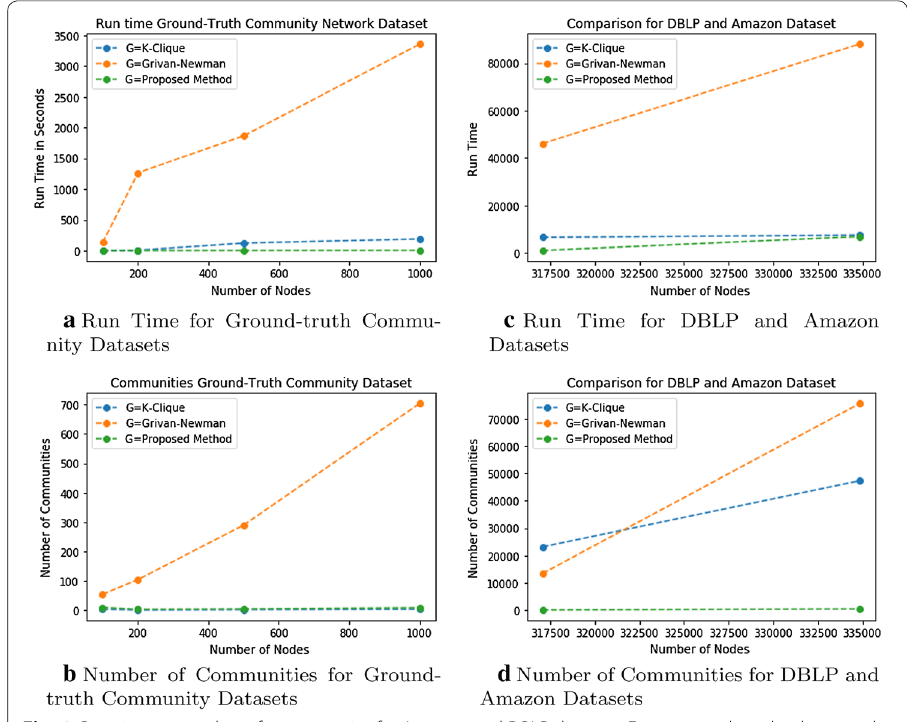
Fig. 6 Run time vs number of communities for Amazon and DBLP datasets. Experimental results showing the run time and the number of communities generated for ground-truth network Amazon and DBLP datasets using the proposed